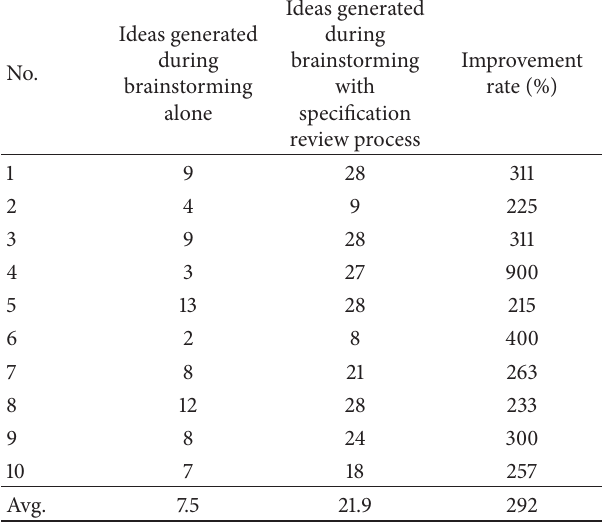
Table 15: Preliminary test results for the proposed method.